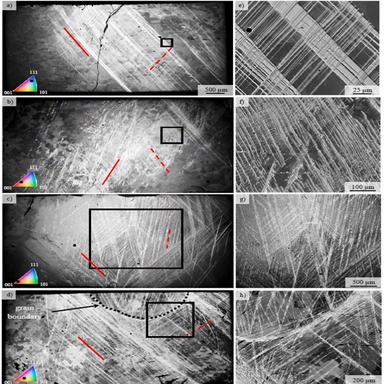
Microstructure of the compression specimens in BSE contrast with marked crystal orientation and traces for primary (solid red line) and secondary (dotted red line) slip systems: (a) near 〈111〉, (b) near 〈113〉, (c) near 〈001〉 and (d) near 〈013〉 according to the loading axis. (e), (f), (g) and (h) show enlarged micrographs of the areas marked by black squares in (a), (b), (c) and (d), respectively. Note that the thin black line visible in the center of the specimen in (a) is a residue of black painting on th